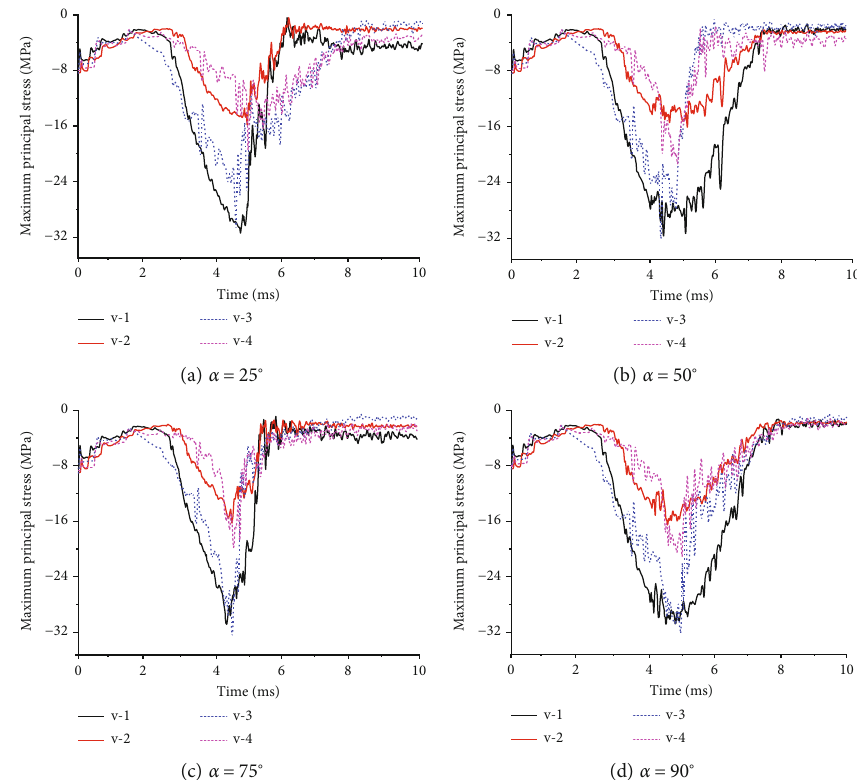
Figure 10: v -1 ~ v -4 maximum principal stress